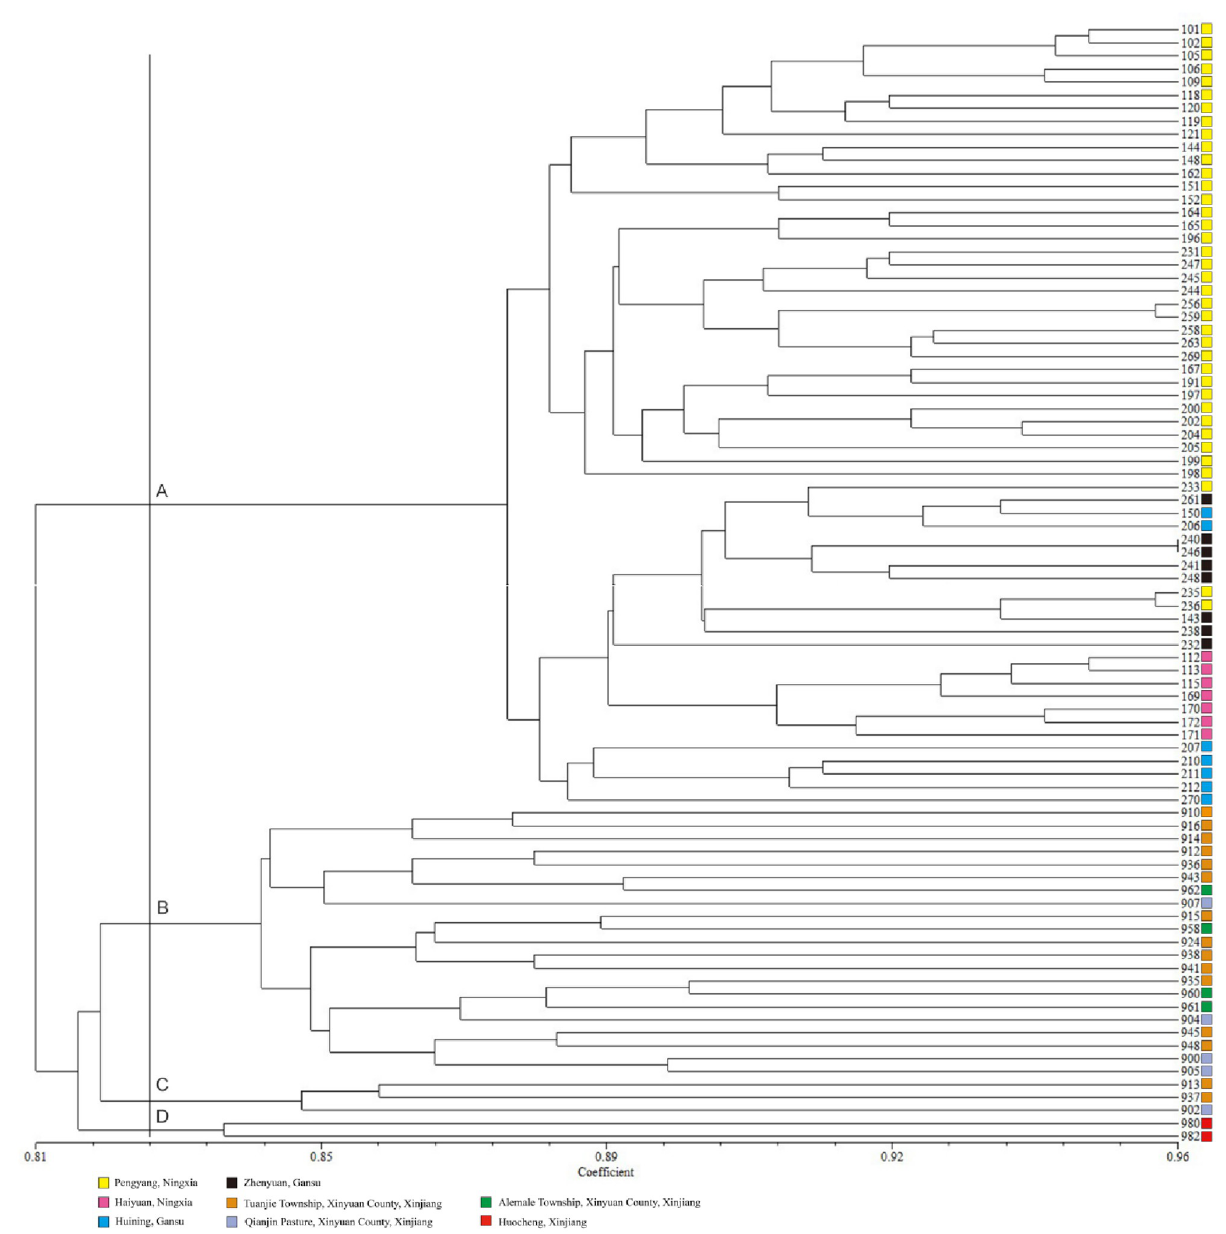
Fig 3. Dendrogram for UPGMA cluster analysis of P . armeniaca var. ansu based on SSR markers.